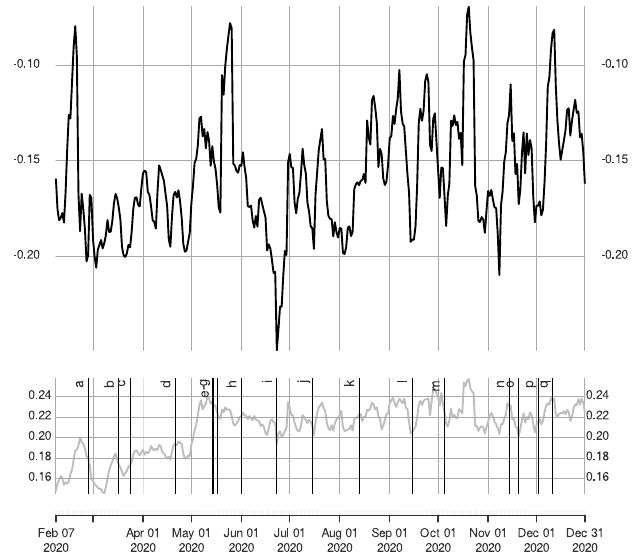
Figure 3. Year–Long time series of daily averaged VADER’s compound sentiment polarity of COVID-19- related tweets, detrended, with its variance and significant events in Mexico . This time series is based on the same dataset collected [6] and restricted to Mexico from 2 February to 31 December 2020. Data were smoothed over via a 7-day rolling mean. Variance is also included for readability, as well as significant events found to cause an impact